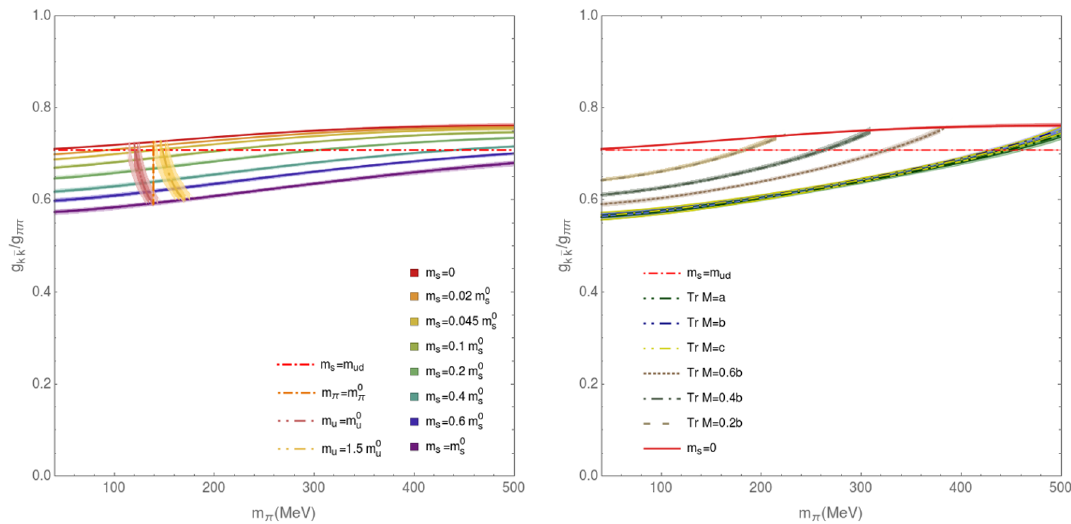
Figure 36 . Ratio of the g